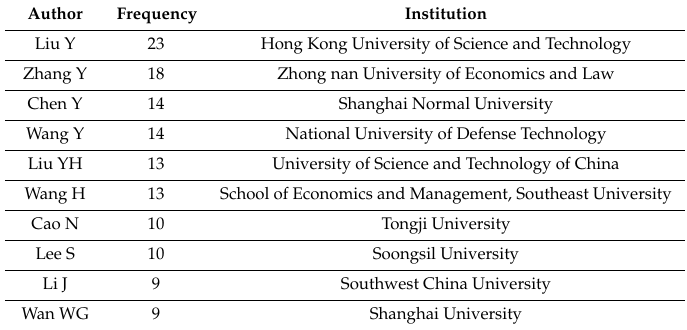
Table 4. Top 10 authors based on frequency.